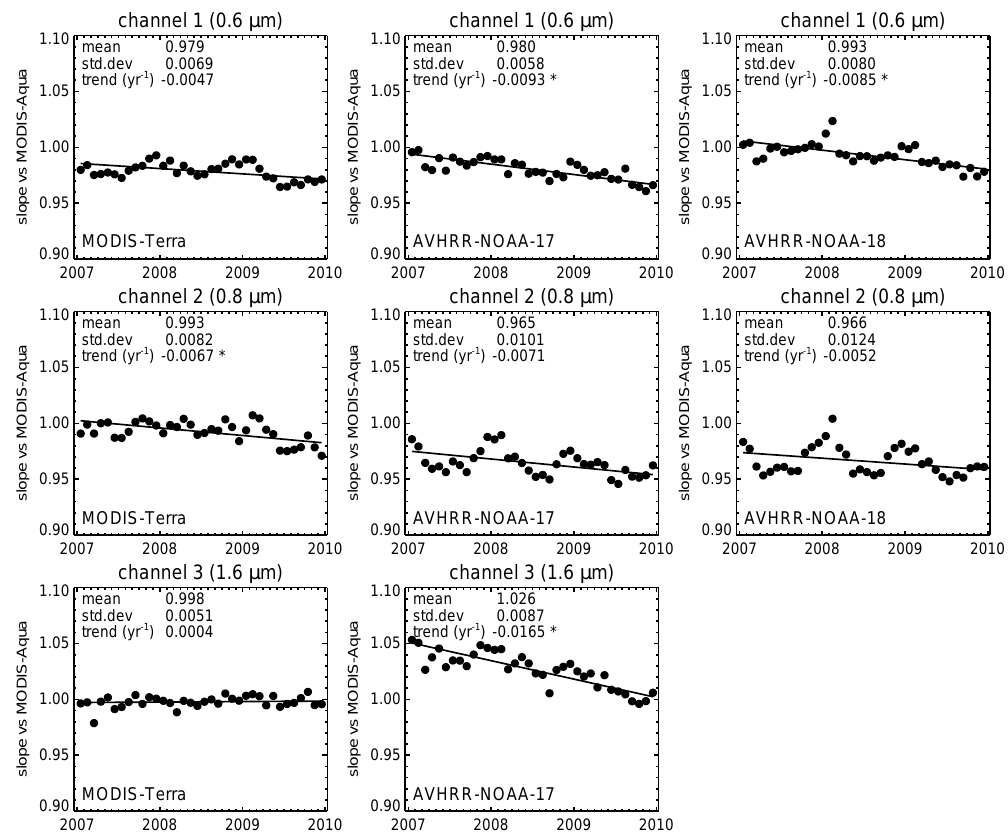
Fig. 7. Time series of inter-calibration slopes of polar-orbiting imagers against MODIS-Aqua using SEVIRI-Meteosat-9 as a transfer instru- ment. Results are shown for MODIS-Terra (left column), AVHRR-NOAA-17 (middle column) and AVHRR-NOAA-18 (right column) and channels around 0.6µm (top row panels), 0.8µm (middle row panels) and 1.6µm (bottom row panels). Note that the 1.6µm channel was not active on AVHRR-NOAA-18. Mean, standard deviation (relative to the trend line), and trend of the inter-calibration slopes are indicated in the plots. Trends that are significant at the 95% level are marked by